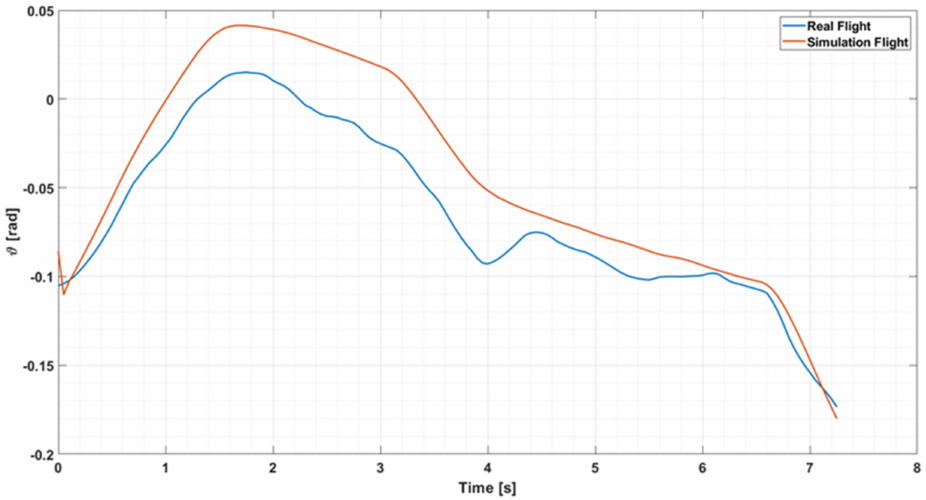
Figure 9. Comparison of real and simulation flight in the longitudinal